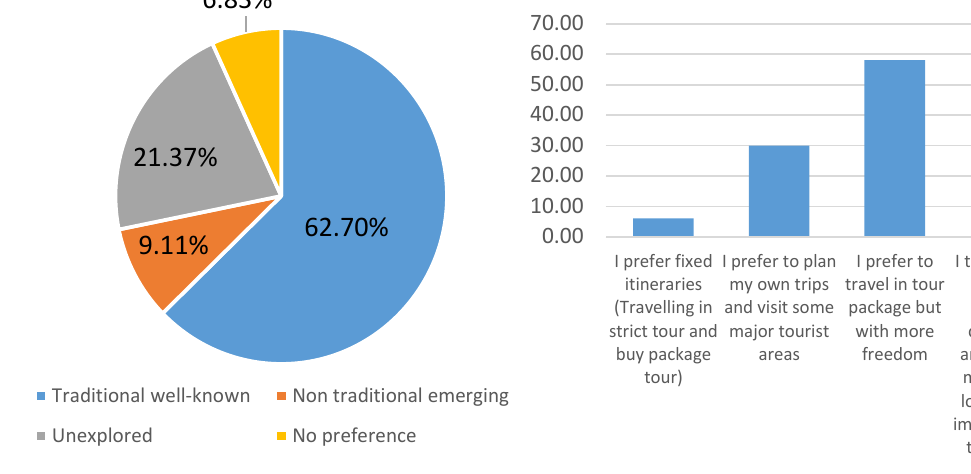
Figure 1. Most preferred destination Figure 2. Travelling